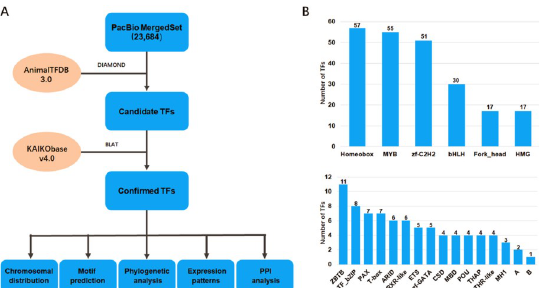
Fig 1. Distribution of TF families identified in the SG. (A) The pipeline of TF identification and analysis. (B) DBD families of TFs in the SG. The x-axis presents the TF family type, and the y-axis presents the number of TFs. The capital letter “A” indicates that the DBD families contain only two TFs, including CP2, DM, E2F, RHD, SF-like, TSC22, and zf-LITAF-like. “B” represents DBD families with only one TF, including AF-4, CBF, COE, CSL, CUT, DACH, ESR-like, GCM, GCNF-like, HPD, HSF, HTH, Miscellaneous, NDT80/PhoG, NF-YB, NGFIB-like, Nrf1, PC4, RFX, Runt, SAND, SRF, TEA, Tub, zf-BED, zf-C2HC, zf-CCCH, and zf-MIZ,